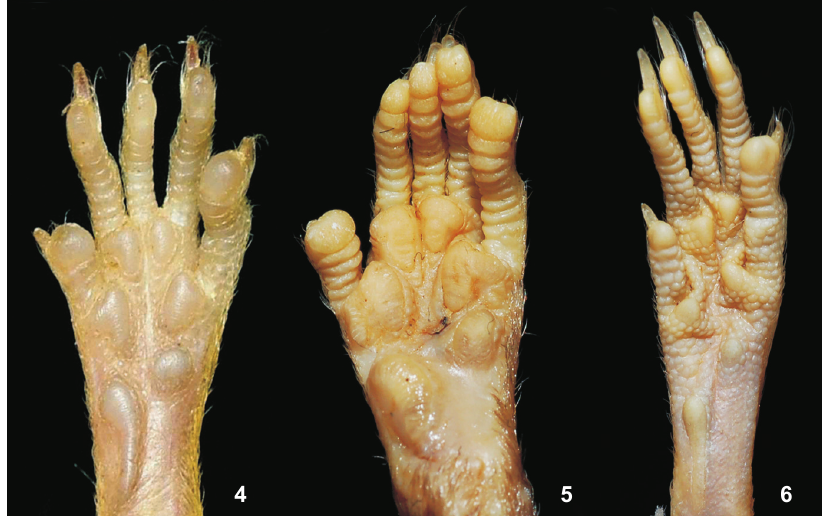
Figures 4-6. Ventral view of the left hindfoot of: (4) Juliomys ossitenuis (MBML 27833 – length of hind foot [HF] = 20 mm); (5) Rhagomys rufescens (AB 401 – HF = 19 mm); (6) Oligoryzomys flavescens (UFES 1255 – HF = 24